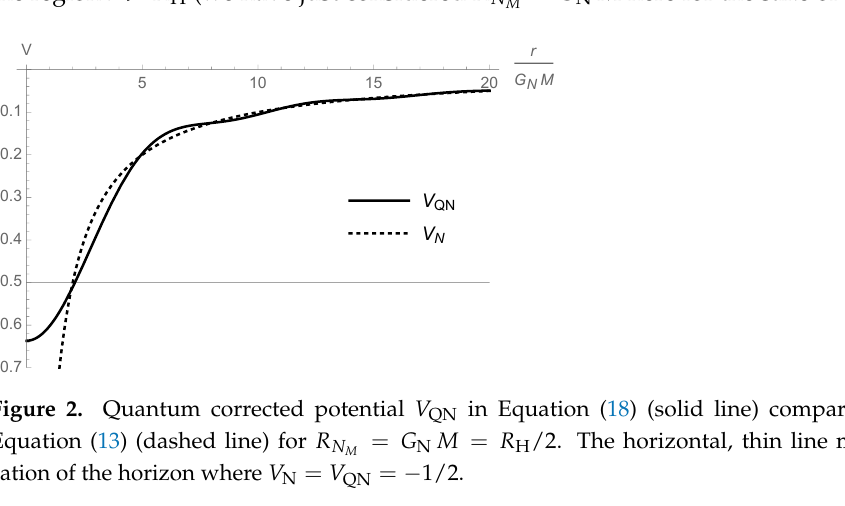
= G = R N M H /2. The horizontal, thin line marks the lo- M